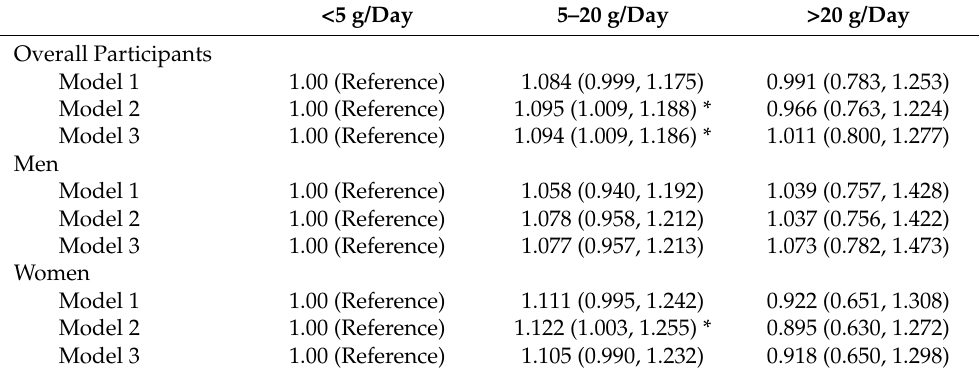
Table 4. Association between free sugars intake and the risk of MetS.